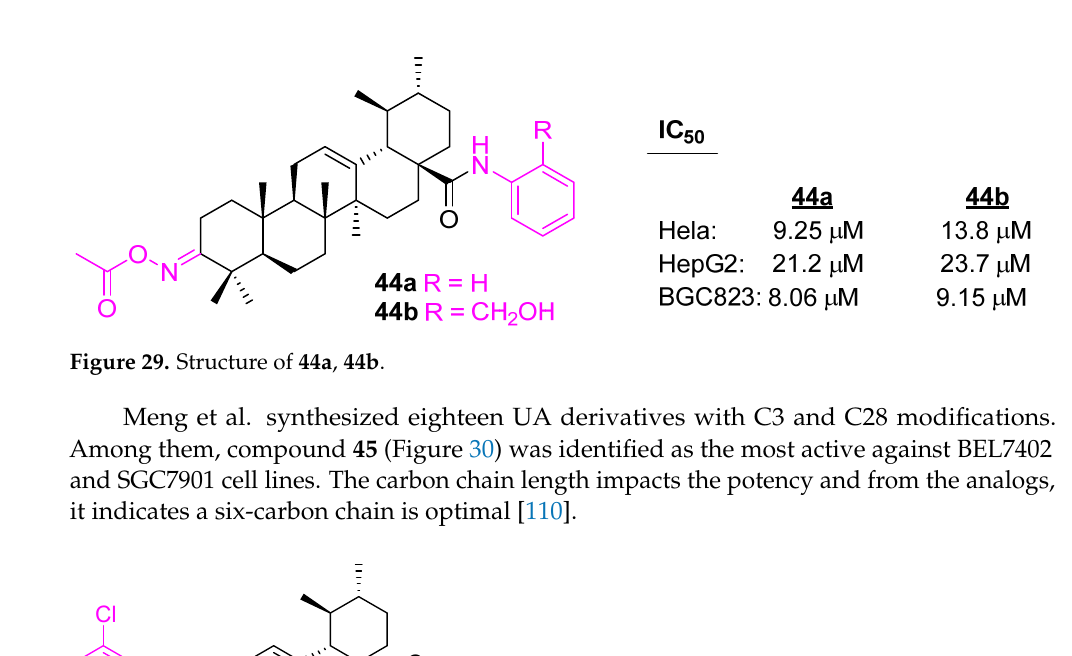
it indicates a six-carbon chain is optimal [110].